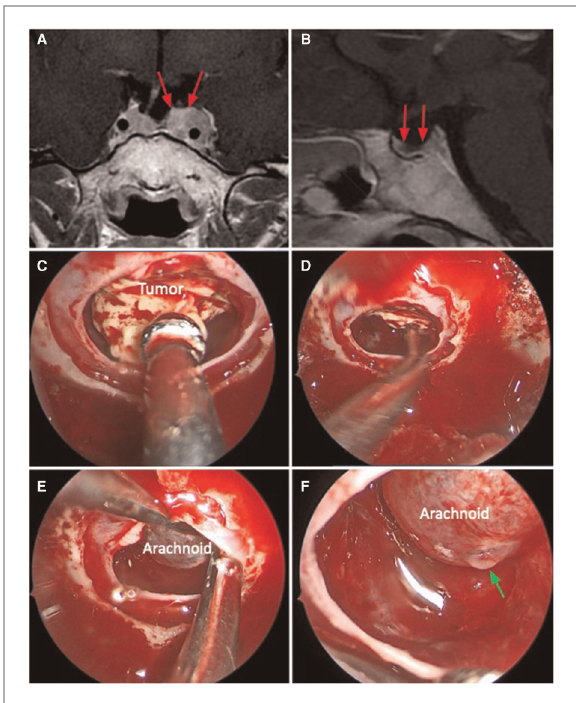
FIGURE 3 Weak sellar barrier. A 31-year-old female patient, with an ACTH produced macroadenoma. ( A,B ) Preoperative MRI: the red arrows indicate the barrier that captures contrast with a thickness less than 1 mm. ( C – F ) Intraoperative images: the barrier constituted only with arachnoid can be seen. The green arrow marks the CSF